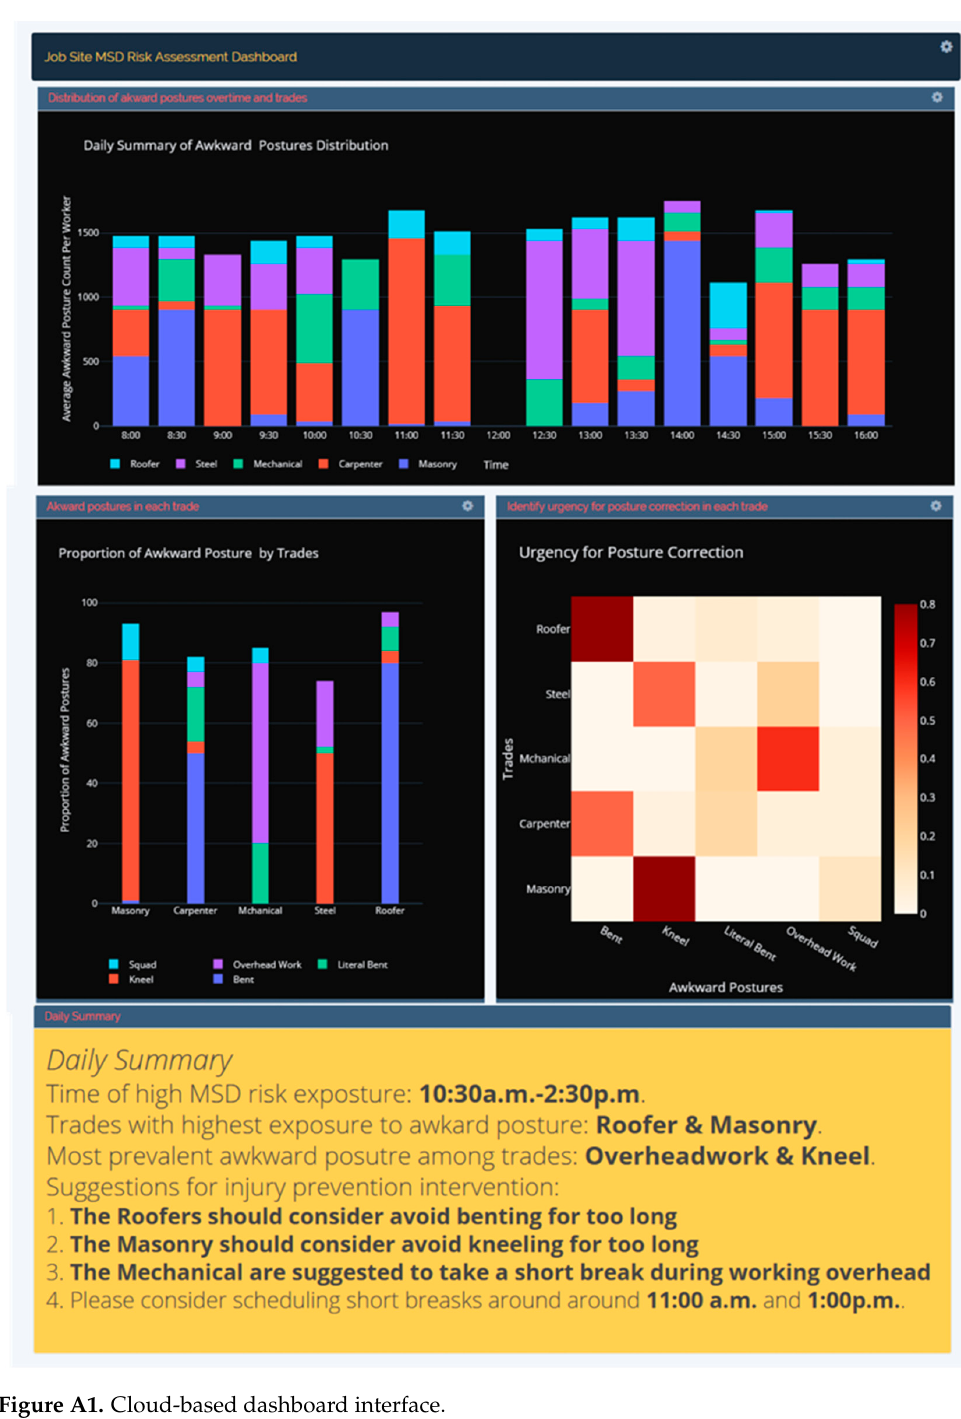
Figure A1. Cloud-based dashboard interface.